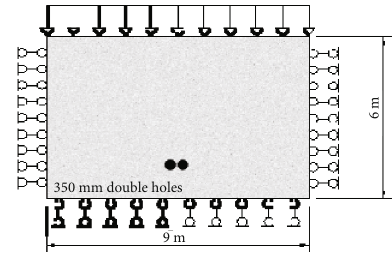
Figure 15: Acoustic emission damage of 350-mm hole cloud map.